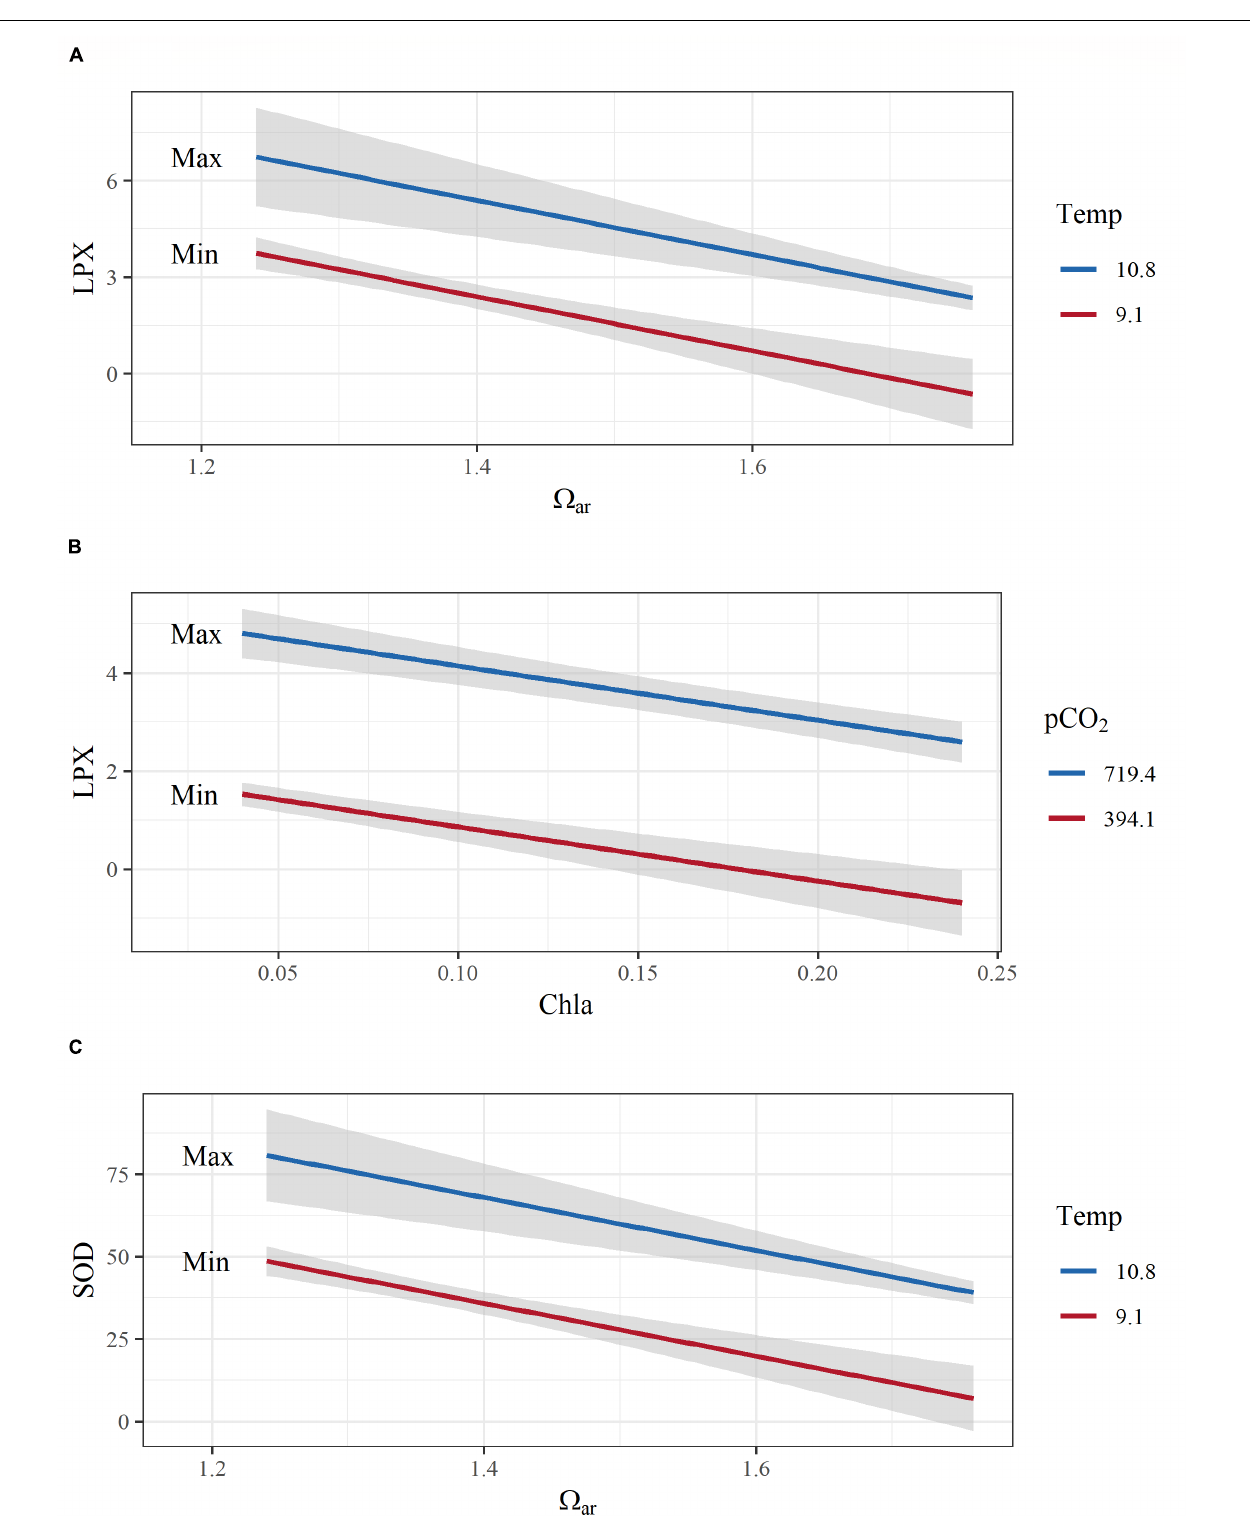
FIGURE 6 | Examples of model interactions of co-occurring environmental variables on pteropod cellular responses. (A) A negative additive effect between aragonite saturation state ( (cid:127) ar ) and temperature on cellular toxicity (lipid peroxidation; LPX); (B) negative additive effects of fluorescence and pCO 2 on LPX; (C) positive additive effects of temperature and (cid:127) ar on antioxidative activity (sodium dismutase, SOD). Both y -axes are transformed to conform to model output. Covarying environmental variables were held constant at the minimum and maximum values in the observed data. Color range depicts the max and min values of the observed parameters.